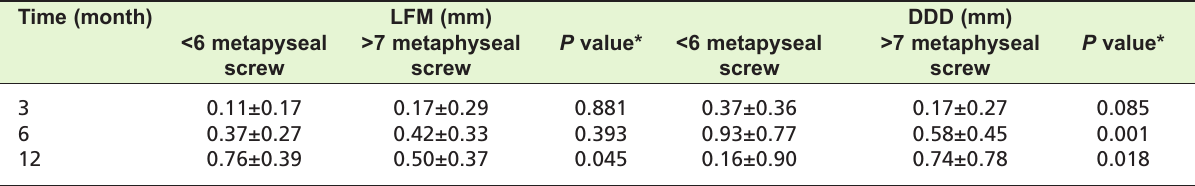
Table II: Evaluation of the radial collapse based on the number of screws used in the metaphyseal region